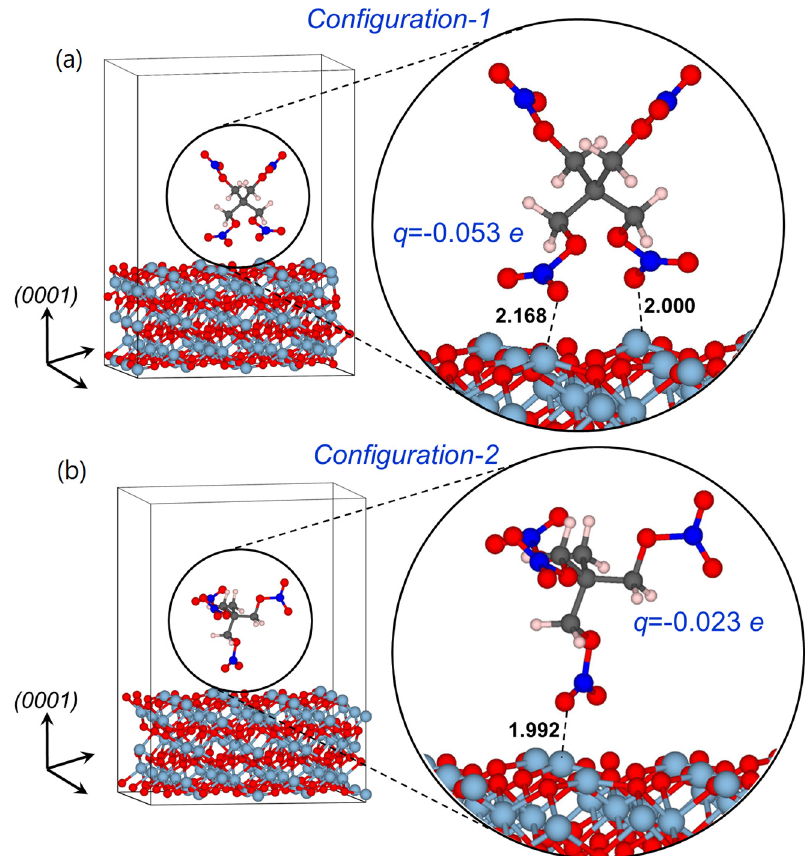
Figure 1. Schematics of the model supercells representing a PETN molecule adsorbed at the (0001) α -Al 2 O 3 surface. The configuration of the PETN molecule corresponds to its relaxed position at the interface between (0001) α -Al 2 O 3 and ( a ) (110) and ( b ) (101) PETN crystal surfaces. Bader charges localized on PETN molecules are also shown.